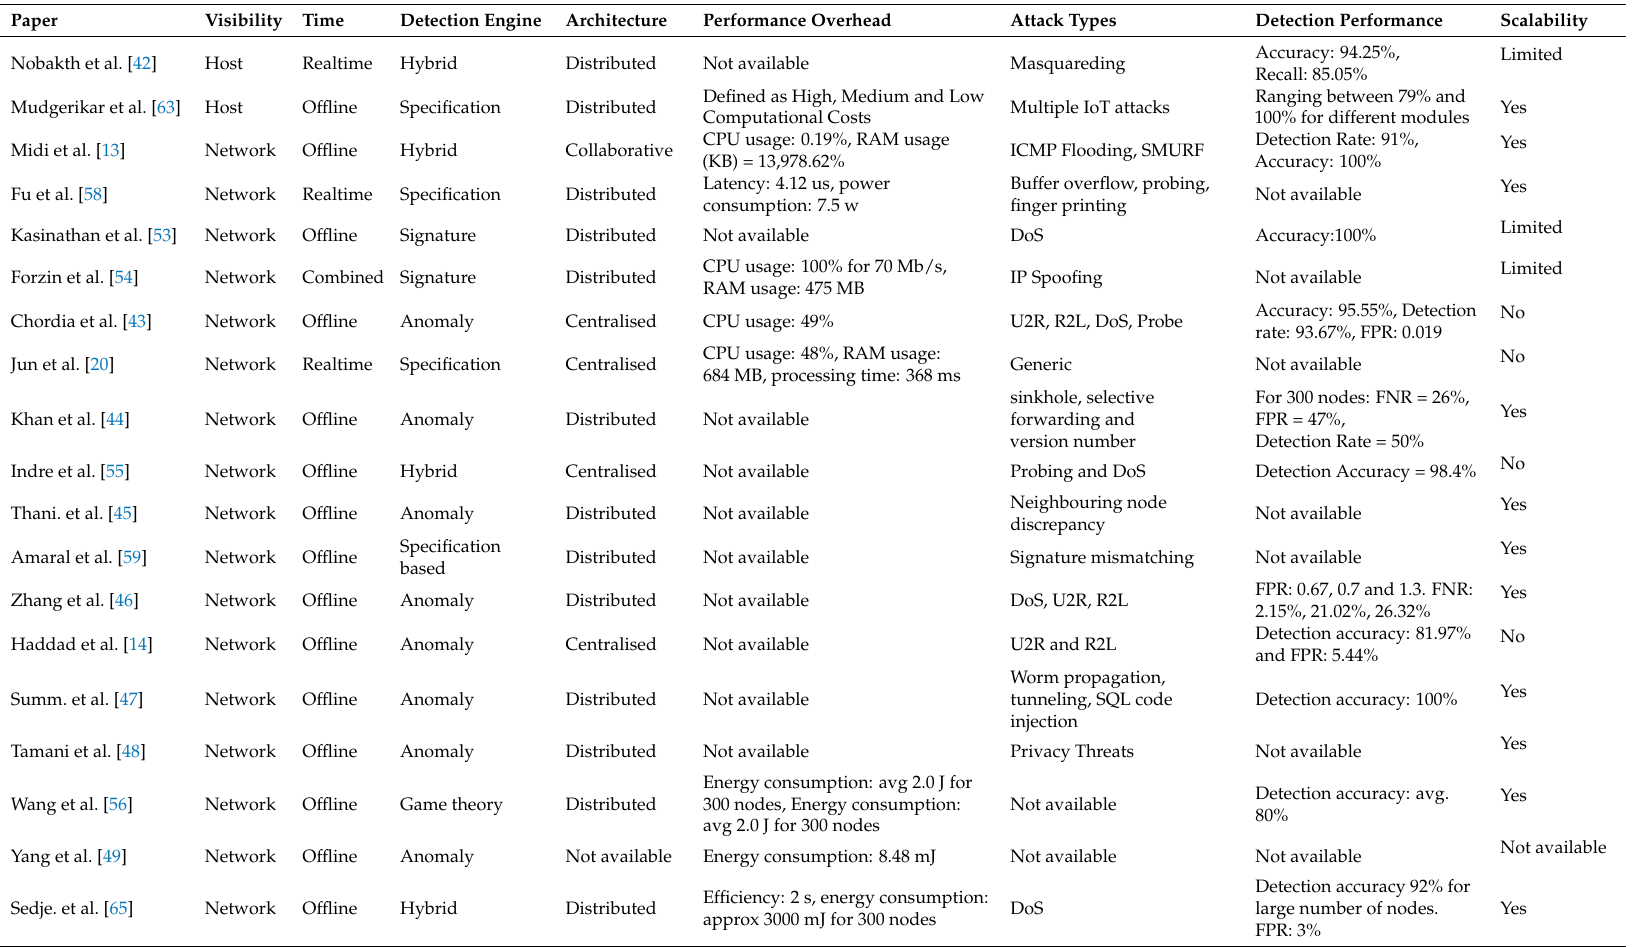
Table 2. Comparative analysis of existing IDS approaches for